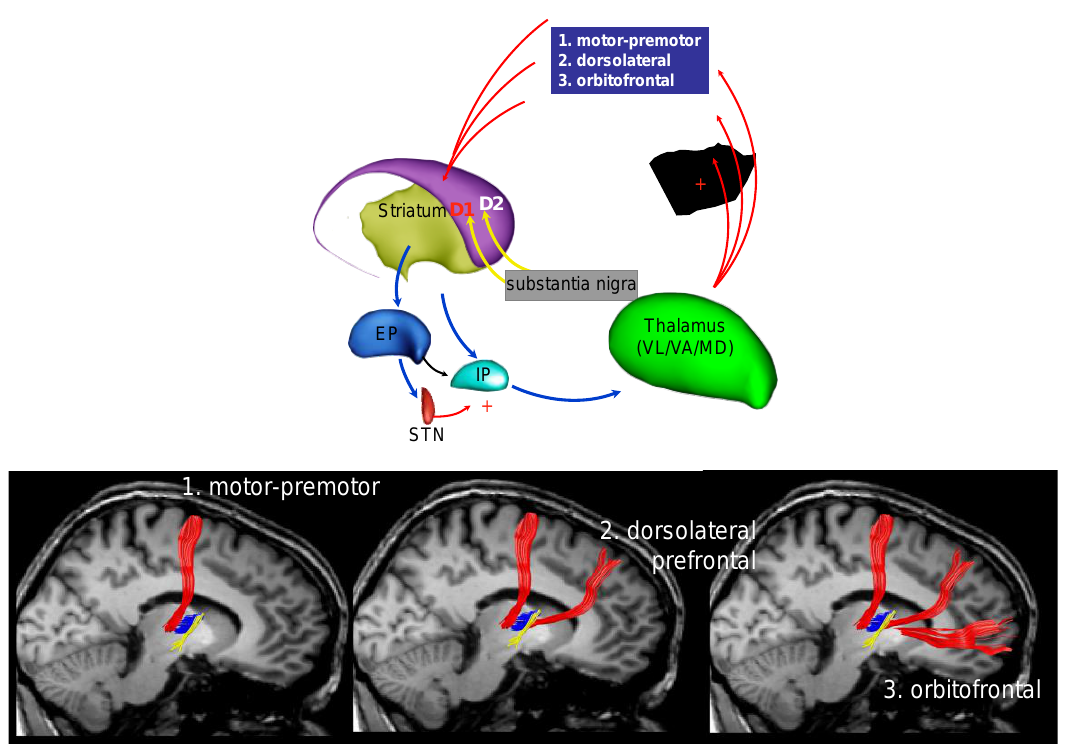
Figure 2. The fronto-striatal circuit (part b).